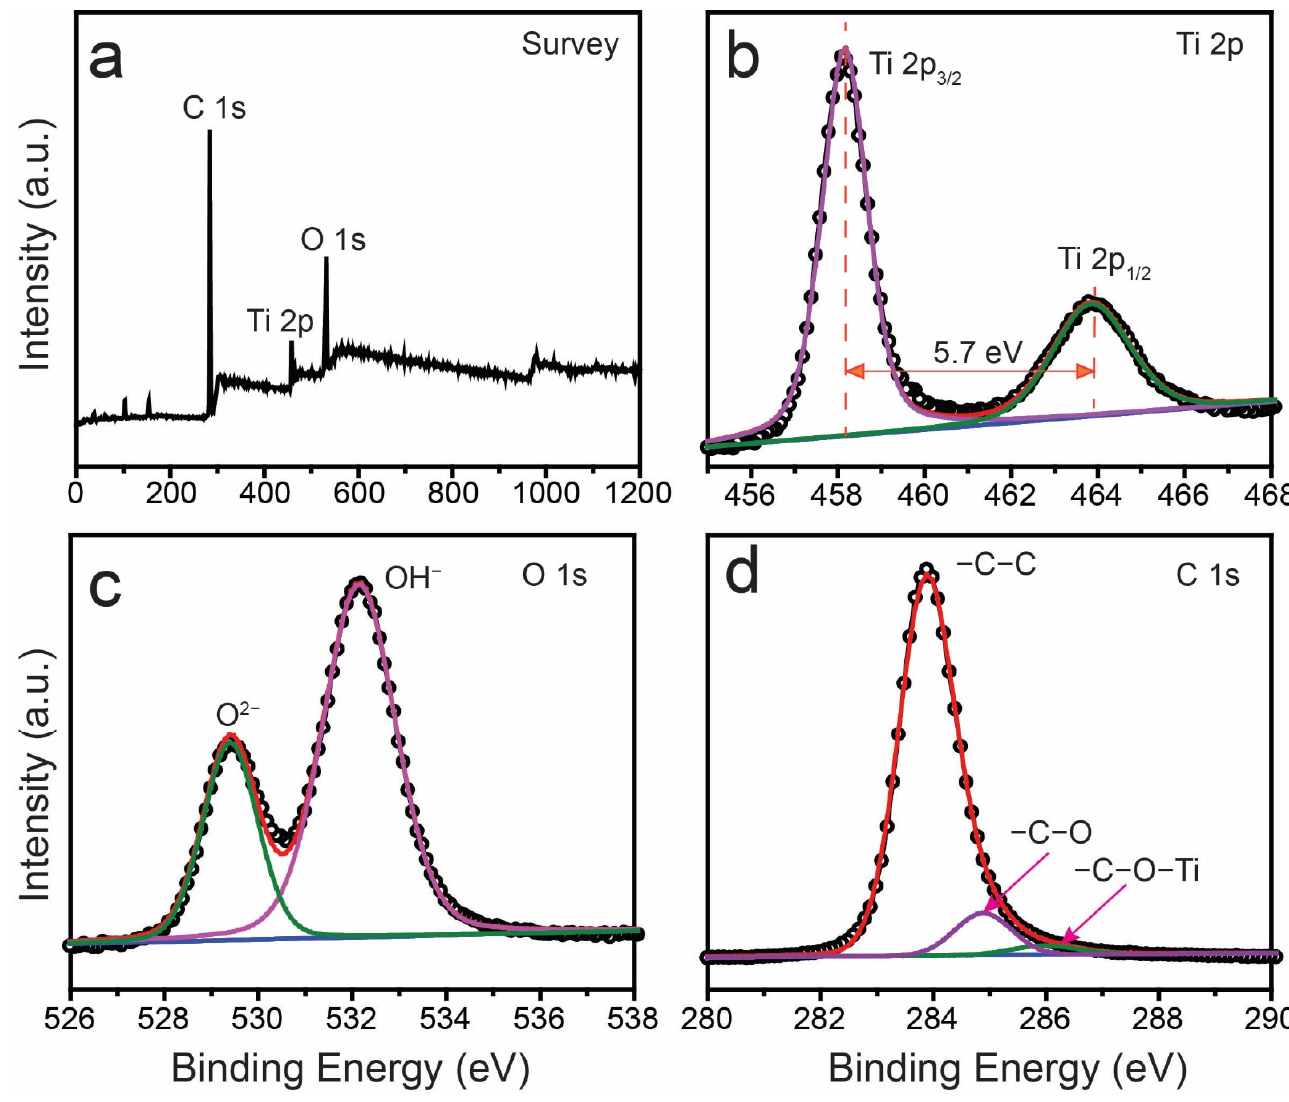
Figure 6. XPS spectra of PPM + TiO 2 NPs: ( a ) survey, ( b ) Ti 2p, ( c ) O 1s, and ( d ) C 1s. Furthermore, FTIR spectroscopy was used to investigate the functional groups and bonding properties of the TiO 2 NPs, the PPM, and the PPM + TiO 2 NPs (Figure 7). The TiO 2 NPs showed a peak at approximately 556 cm − 1 because of the Ti–O vibrations stretching mode (Figure 7a). Additionally, the peaks observed at 1635 cm − 1 and a broad peak at 3200–3500 cm − 1 correspond to the bending and stretching vibrations of O–H, respectively, from surface-adsorbed water molecules [26,27]. In Figure 7b, the PPM peaks at 1456 and 1375 cm − 1 are associated with the bending vibration of –CH 2 and the symmetric deformation of –CH 3 , respectively. In addition, peaks for –CH 3 and –CH 2 symmetric stretching vibrations are observed at 2874 and 2839 cm − 1 , respectively. The –CH 3 and –CH 2 asymmetric stretching vibrations are attributed to the peaks at 2954 and 2917 cm − 1 , respectively